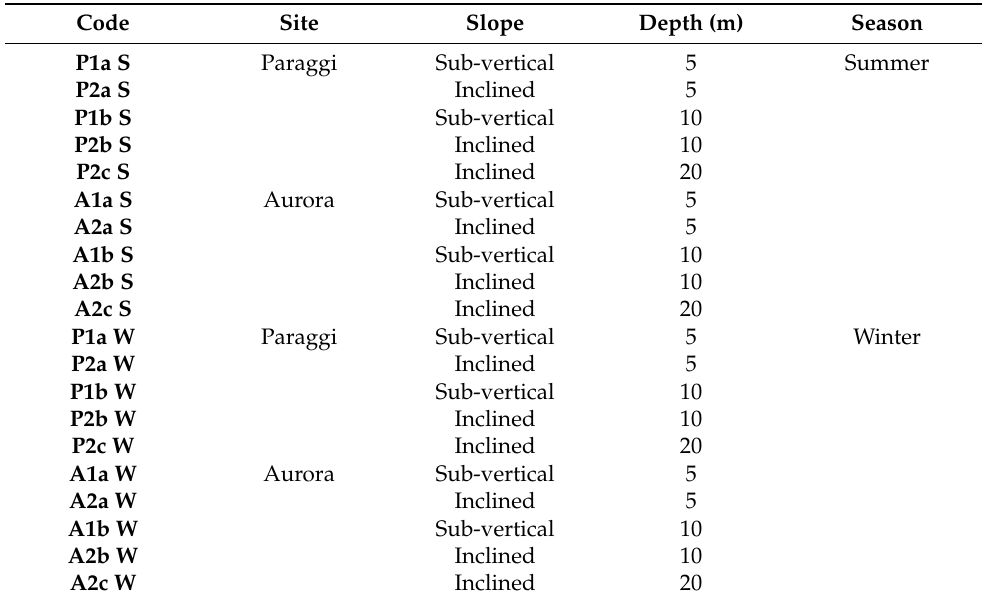
Table 1. Sampling station identification codes: sampling site (P = Paraggi; A = Aurora), slope of the substratum (1 = sub-vertical; 2 = inclined), depth of the station (a = 5 m; b = 10 m; c = 20 m), season (S = summer; W =